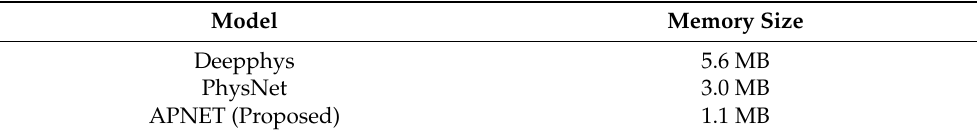
Table 8. Comparison of memory size with representative algorithms.